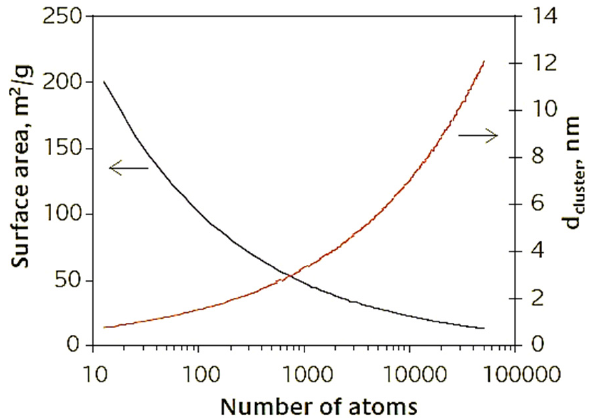
Figure 1. AuNPs atoms number as a function of surface area and size [17].